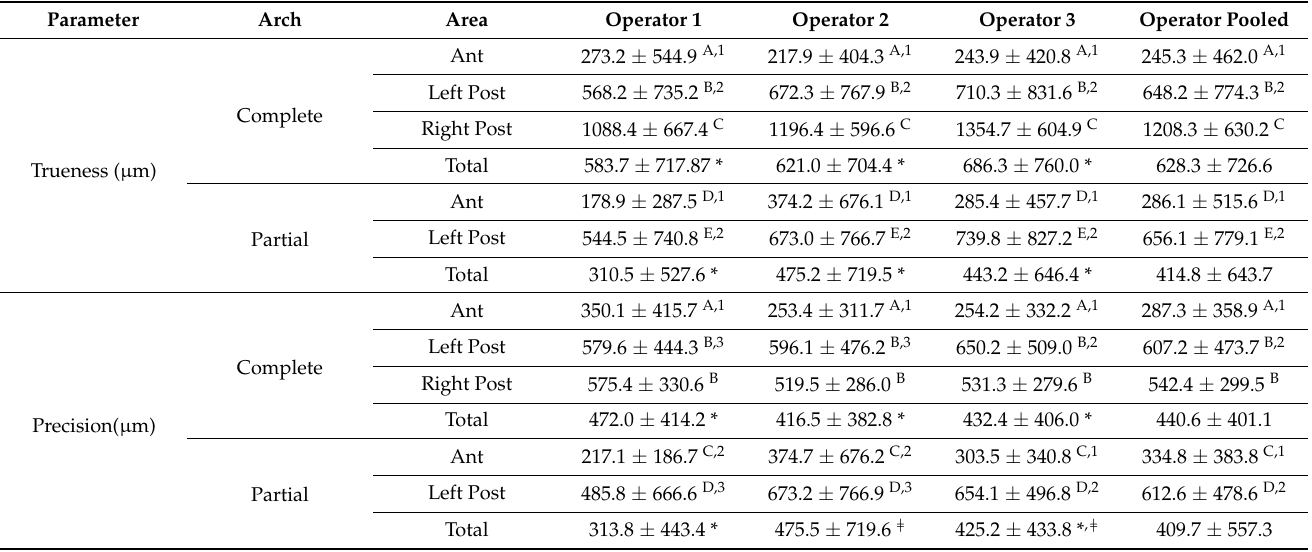
Table 2. Mean and standard deviation values for trueness and precision of complete and partial arch scans from different operators and pooled data from all operators.